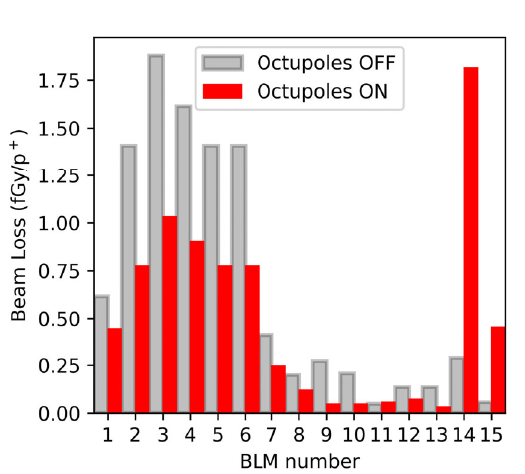
(b) Beam loss (normalised to extracted intensity) along LSS2, demonstrating a loss reduction of 42% at the first 5 BLM’s next to the